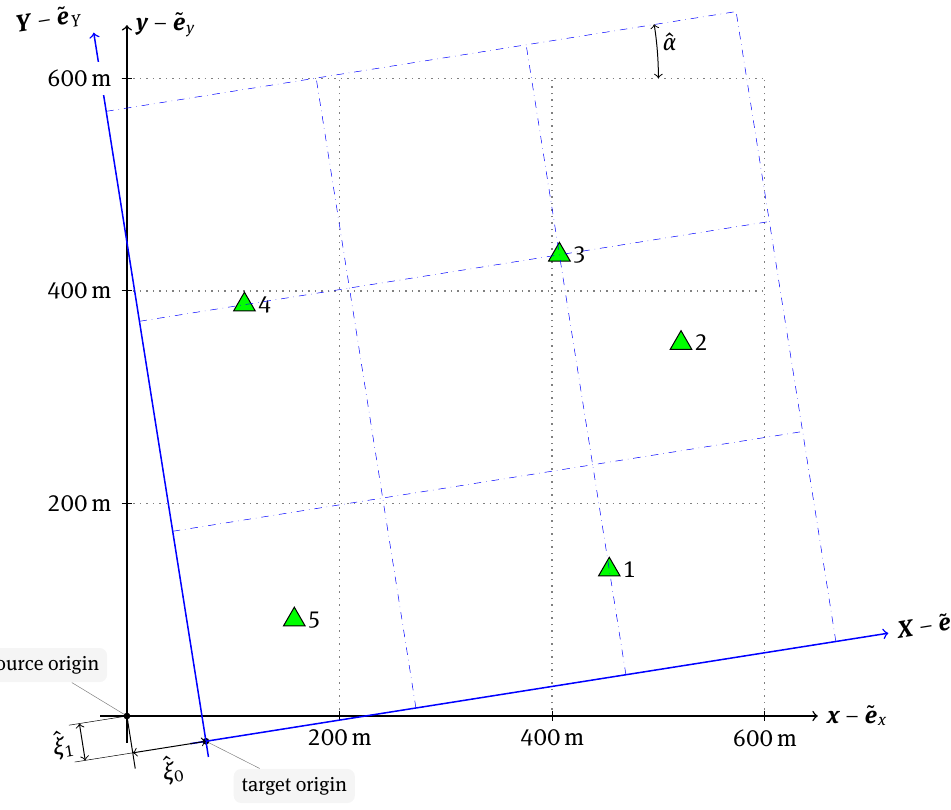
Fig. 1. Map view of the five data points before and after the 2-D similarity transformation. The dotted lines represent a grid for the adjusted coordinates ( x − ˜ e x , y − ˜ e y ) in the source system, and the dash-dotted lines represent a (rotated) grid for the adjusted coordinates ( X − ˜ e X , Y − ˜ e Y ) in the target system. The origin of the source system has coordinates (ˆ ξ 0 , ˆ ξ 1 ) in the target system. The grid interval for both grids is 200